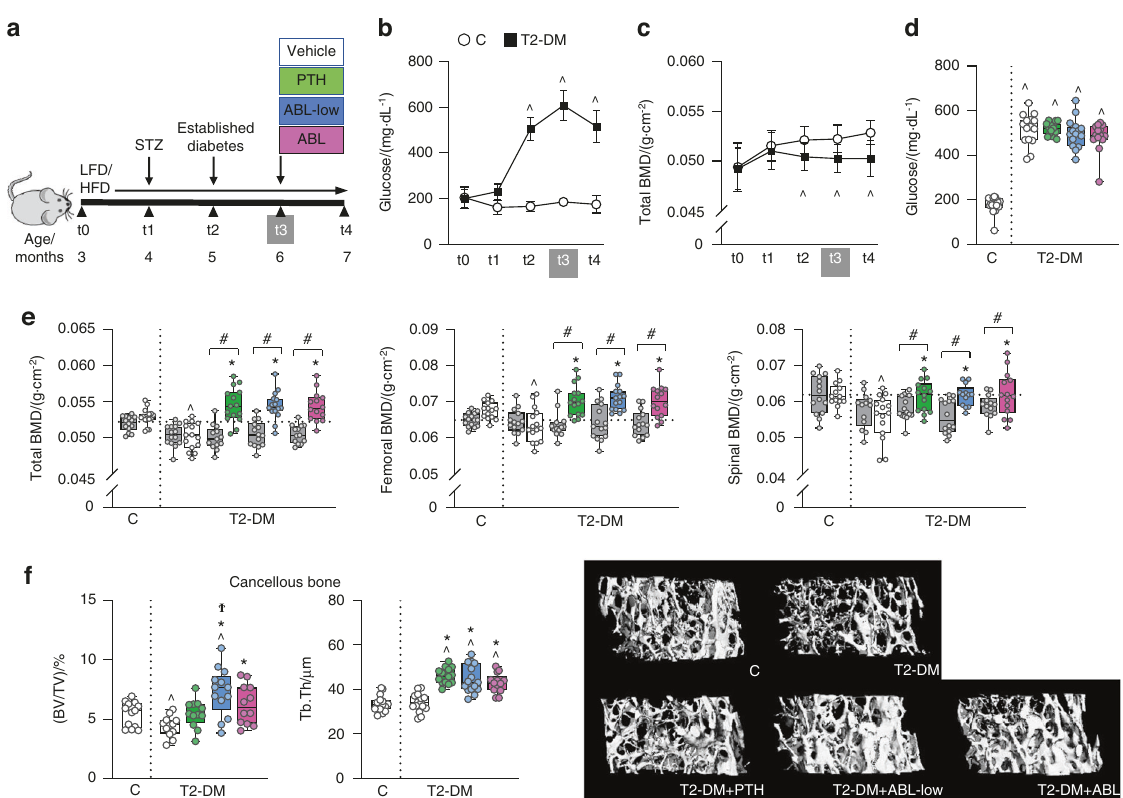
Fig. 1 PTH and both doses of ABL restored BMD and increased cancellous bone in diabetic mice. a Study design depicting the preclinical T2- DM model. Male C57BL/6 mice were fed a low-fat diet (LFD) or a high fat diet (HFD) starting at t0 until the end of the experiment. At t1, HFD- fed mice were injected with streptozotocin (STZ) (T2-DM) and LFD-fed mice, with buffer (C). At t2, blood glucose was measured to con fi rm DM, and following an additional month to fully develop the bone disease at t3, mice were administered with vehicle, PTH or ABL daily for 4 weeks (t4). Longitudinal analysis showing the effect of DM on b blood glucose, and c total bone mineral density (BMD). d Glucose levels after treatment (at t4). e Total, femoral and spinal BMD before treatment (at t3, grey bars) and after treatment (at t4) with vehicle (white bars), PTH (green bars) or ABL (blue and pink bars). f Micro-CT analysis of femur cancellous bone: trabecular bone volume/tissue volume (BV/TV) and trabecular thickness (Tb.Th), after treatment with PTH or ABL and representative images. n = 12 – 15 mice per group. Data are presented as box & whisker plots where each dot represents a mouse. ^ P < 0.05 versus C mice by one-way ANOVA with post hoc Dunnet ’ s correction; * P < 0.05 versus T2-DM mice treated with vehicle; and # P < 0.05 versus t3, by one-way ANOVA with post hoc Tukey ’ s effects of diabetes on bone mass and structure, and to increase bone strength. RESULTS PTH and ABL restored the bone lost with T2-DM The bone anabolic agents were tested in a model of T2-DM induced by a combination of high fat diet (HFD) and streptozo- tocin (STZ) in skeletally mature male C57BL/6 J mice (Fig. 1a). HFD/ STZ (T2-DM) caused persistent overt hyperglycemia with blood glucose > 250 mg·dL − 1 compared to non-diabetic mice fed low fat diet (LFD, C mice), which was fi rst detected 4 weeks after initiating the STZ injections (at t2) and remained elevated for the entire study (Fig. 1b). Body weight was increased in T2-DM mice compared to C after 4 weeks of HFD (at t1) (Fig. S1a), due to a gain in fat mass. T2-DM caused signi fi cant reduction in BMD as quanti fi ed by longitudinal DEXA analysis, con fi rming the devel- opment of bone disease (Fig. 1c and Fig. S1b). Decreased BMD was fi rst detected in the spine at t1 and in total body at t2, and remained reduced compared to C throughout the study, whereas the decreased femoral BMD was detected at the end of the study. Four weeks of treatment with equimolar doses (24 pmol·g − 1 restored the bone lost caused by T2-DM at all sites (Fig. 1e). Similar increases in BMD were induced by half dose of ABL (ABL-low,